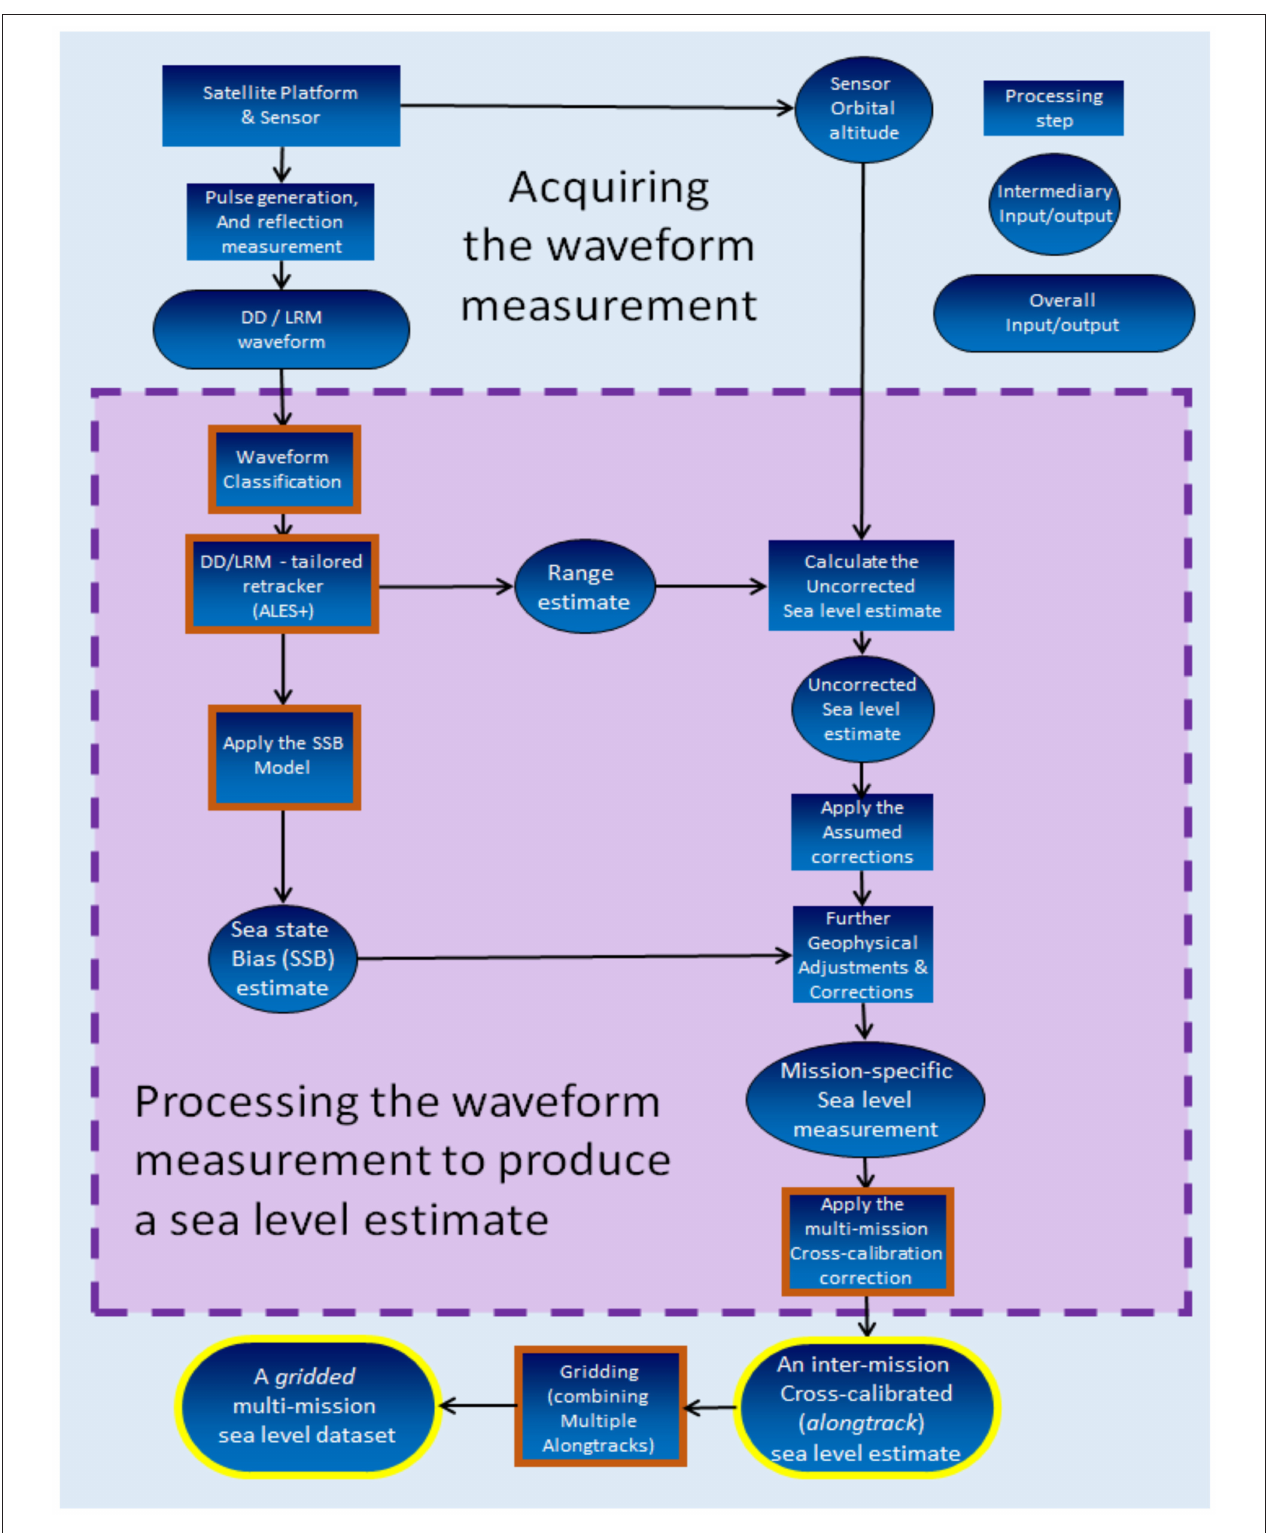
FIGURE 1 | From measurement to corrected sea level estimates delivered as along-track and gridded datasets. A simple flowchart of the origins of the waveform data, and how it is processed to produce the ESA Baltic SEAL estimate of sea level. Process steps which are enhanced and tailored for use in BS, are highlighted in orange.